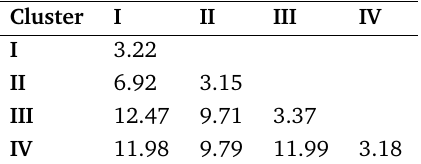
Table 8. Mean intra- and inter-cluster Mahalanobis (D) distances of 80 accessions of Stylosanthes scabra Vogel. Embrapa Cerrados, Planaltina, DF,